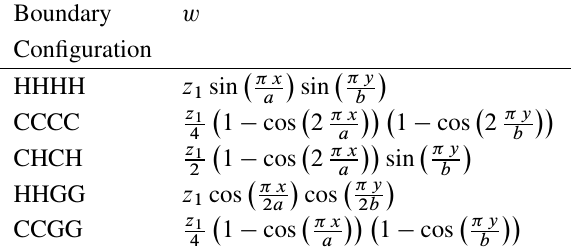
Table 1. Approximate lateral displacement field .w.x; y// variations assumed in Ritz method for various rectangular plate configurations